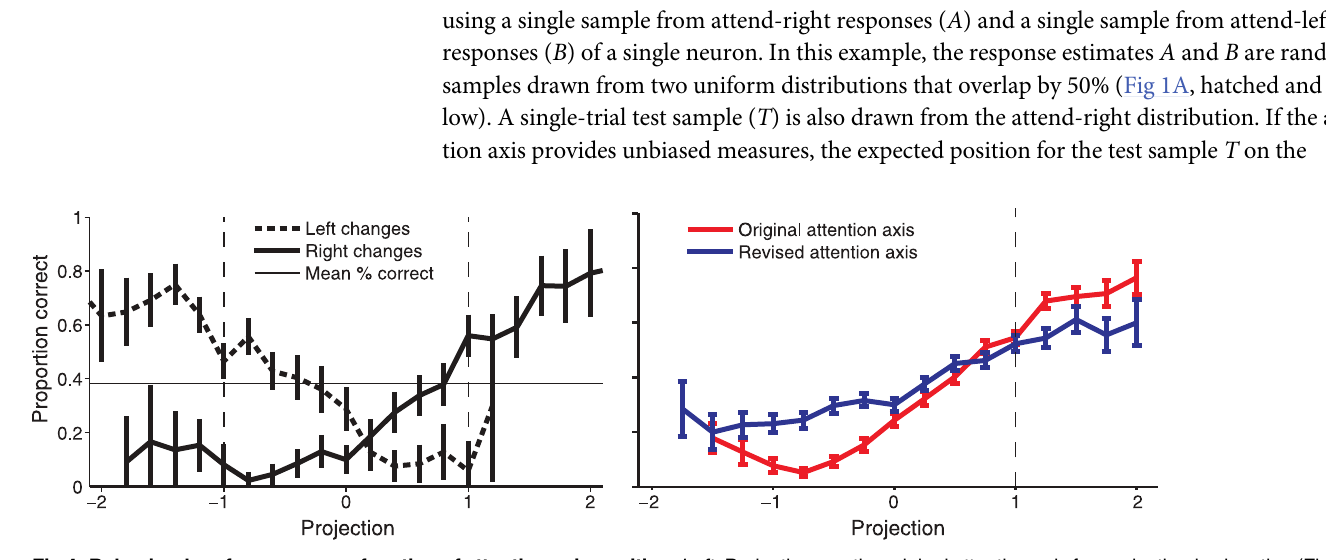
Fig 4. Behavioral performance as a function of attention axis position. Left , Projections on the original attention axis for each stimulus location (Fig 2F from [5]). Horizontal line indicates mean proportion correct across trials. Right , Same data combined across stimulus locations plotted on the original attention axis (red line) and re-plotted on the revised attention axis (blue